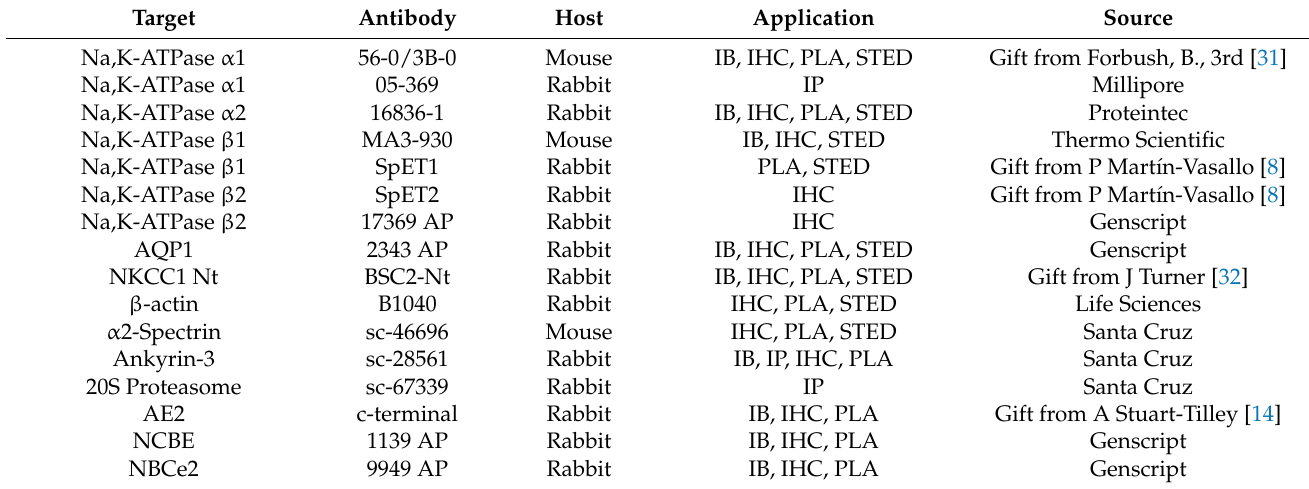
Table 7. Primary antibodies used in this study. IB: Immunoblotting, IP: Immunoprecipitation, IHC: Immunohistochemistry, PLA: Proximity ligase assay, STED: Stimulated emission depletion